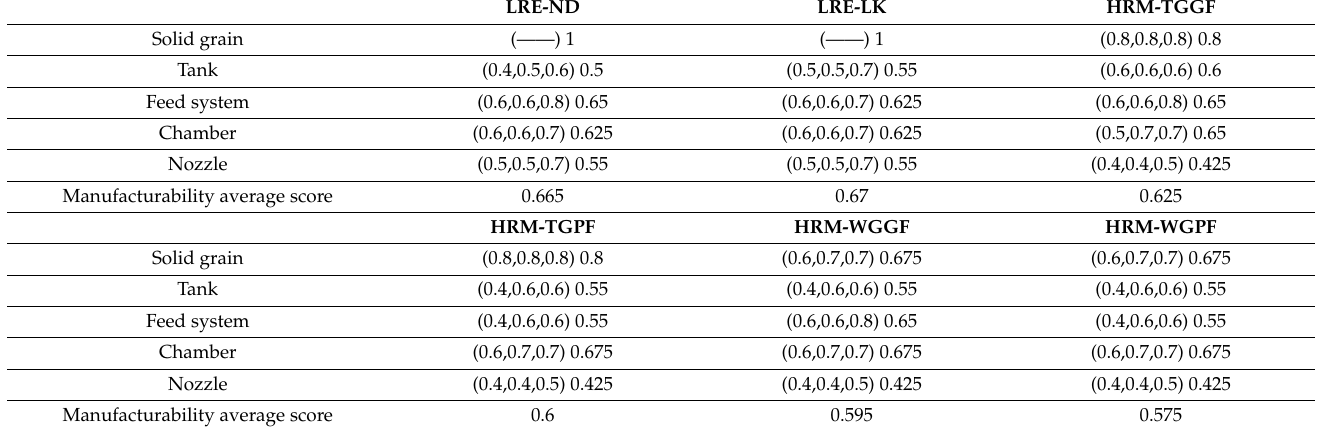
Table 3. Manufacturability results of expert evaluations.